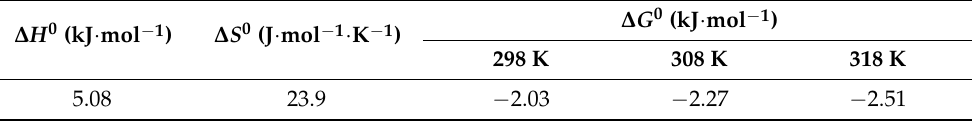
Table 3. Results of thermodynamic